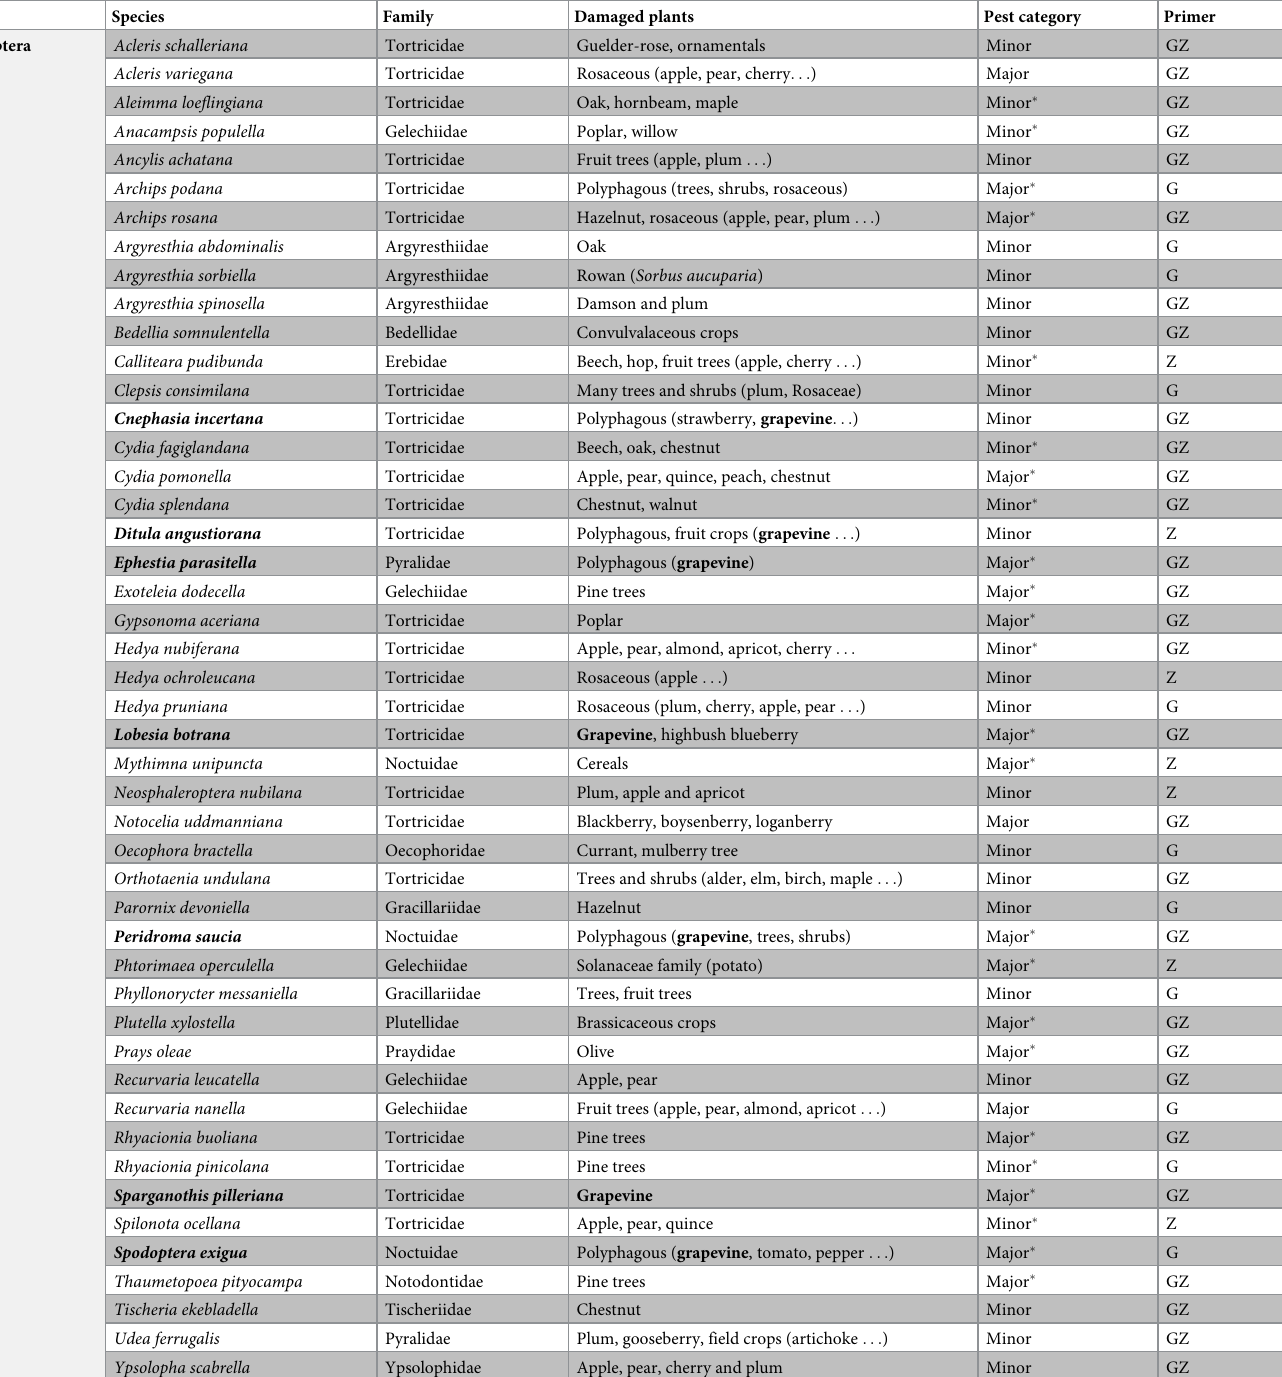
Table 1. List of pest species identified in faeces of R . hipposideros , affected hostplants, their corresponding pest category and the primer set with which they were detected. Species affecting grapevine are highlighted in bold. Asterisks refer to species considered as pest locally in the Iberian Peninsula of other crops. Primer set(s): (G) Gillet, (Z) Zeale, (GZ) both.